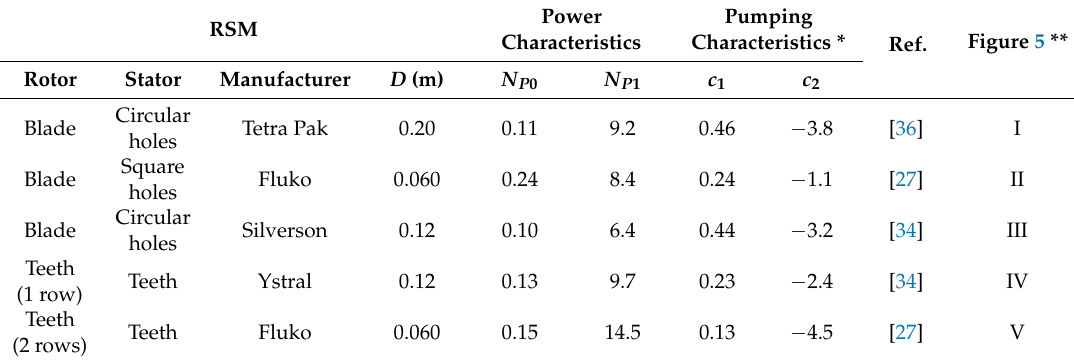
Table 1. A comparison of power and pumping characteristics of some continuous mode rotor-stator mixers (RSMs). RSM